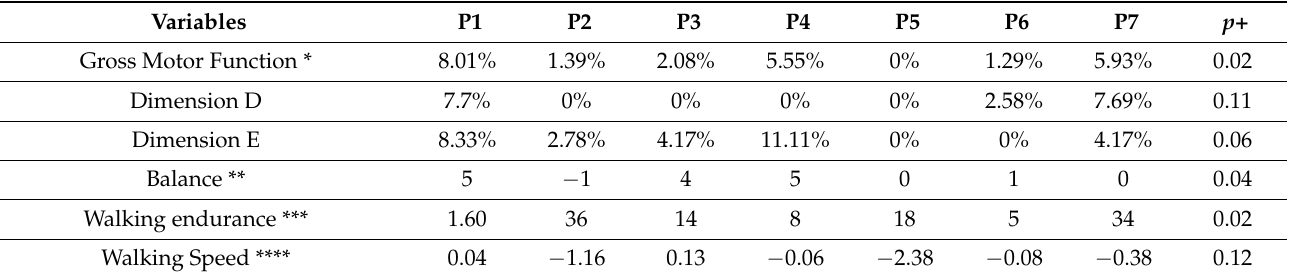
Table 4. Long-term effect of the intervention V 3 − V 1